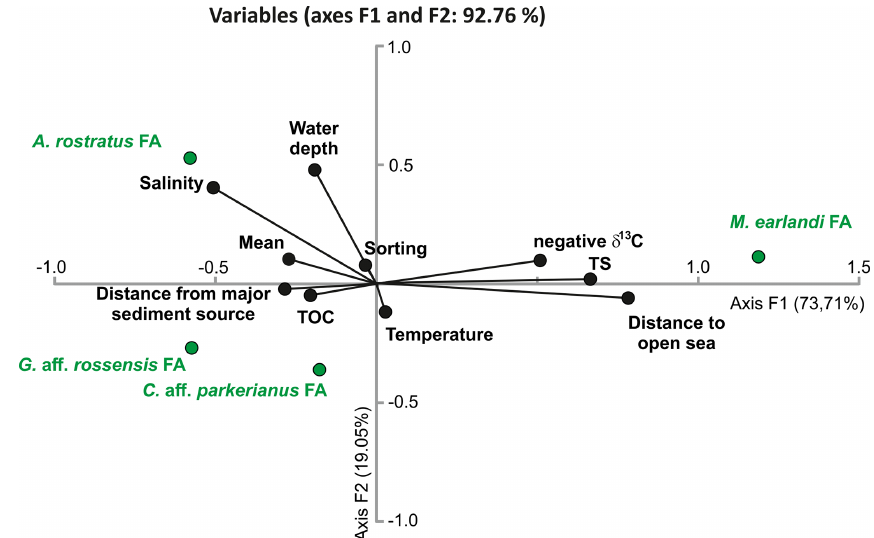
Figure 10. CCA plot of the faunal assemblages (FAs) defined by PC analysis (in green) with various parameters (in black), including location (water depth, distance from major sediment source, and distance to open sea), environmental parameters (salinity and temperature), and sediment properties (total organic carbon (TOC) and its isotopic composition, total sulfur (TS), mean grain size, and